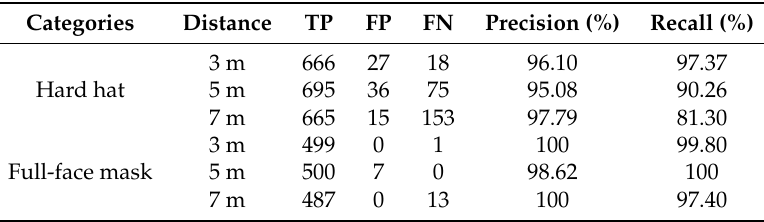
Figure 6. Identification examples on the testing dataset. Table 4. Identification results under different